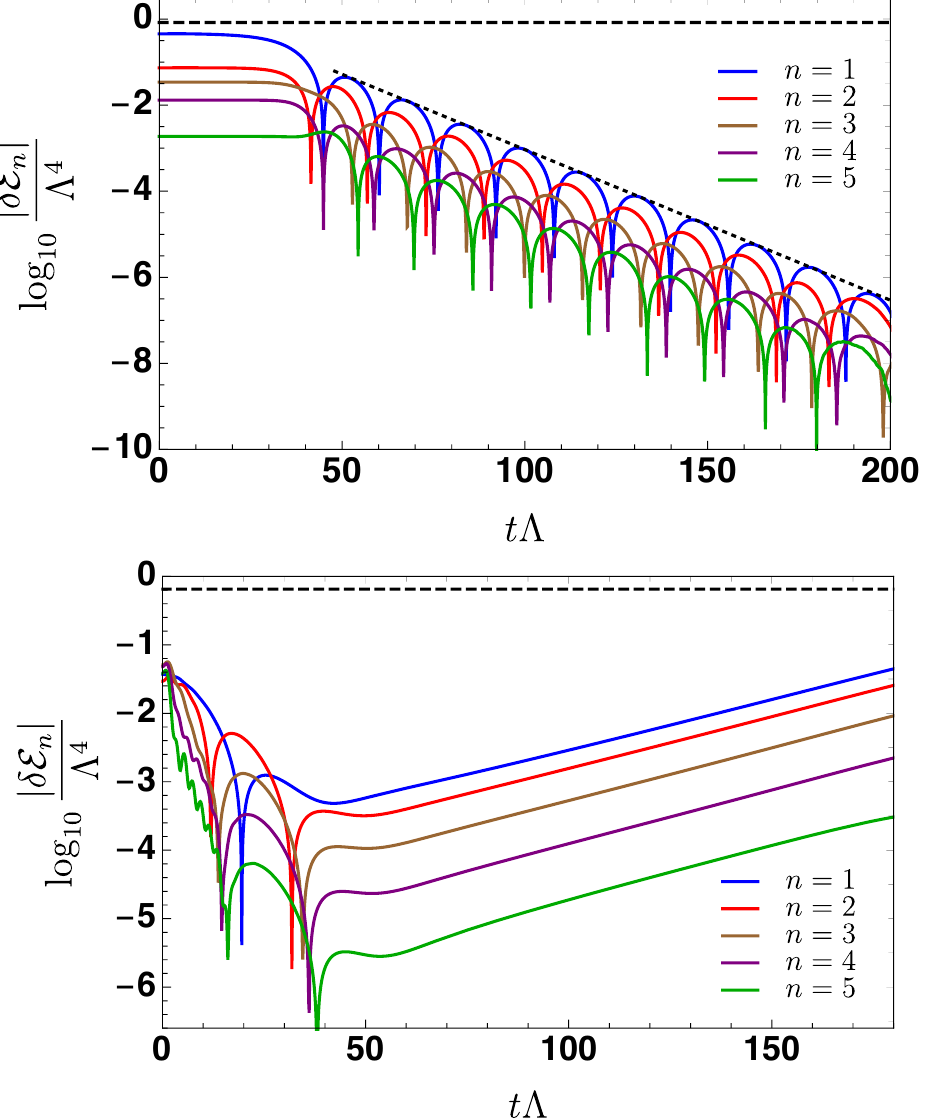
Figure 25 . (Top) Time evolution of some Fourier modes of a perturbation around the type I, inhomogeneous, static configuration X a of figure 24(top-right) with ˆ E ’ 0 . 831460 , ˆ L ’ 11 . 501849 . The dashed horizontal line indicates the average energy density of the box. The region with clear exponentially damped oscillations corresponds to times where the subdominant modes have decayed sufficiently, and the dominant mode has leading amplitude. The dotted line corresponds to a fit to the envelope, from which we extract the imaginary part of omega. The fact that no mode grows in time indicates that X a is locally dynamically stable. (Bottom) Time evolution of some Fourier modes of a perturbation around the type III, inhomogeneous, static configuration X c of figure 24(bottom-right) with ˆ E ’ 0 . 651 , ˆ L ’ 11 . 501849 . In this case the leading mode grows exponentially in time, indicating that X c is locally dynamically